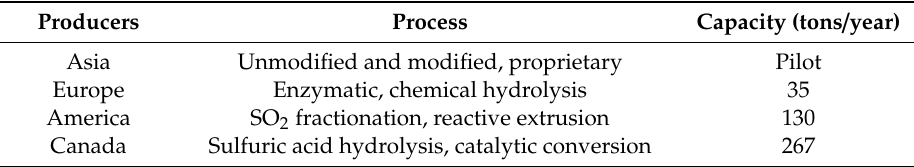
Table 4. World production of cellulose nanocrystals, 2018 (per